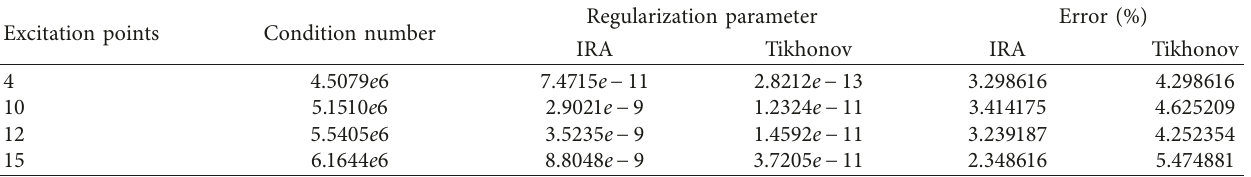
Table 6: Comparisons of the IRA with the Tikhonov regularization for the identified harmonic load errors under differential excited points. Excitation